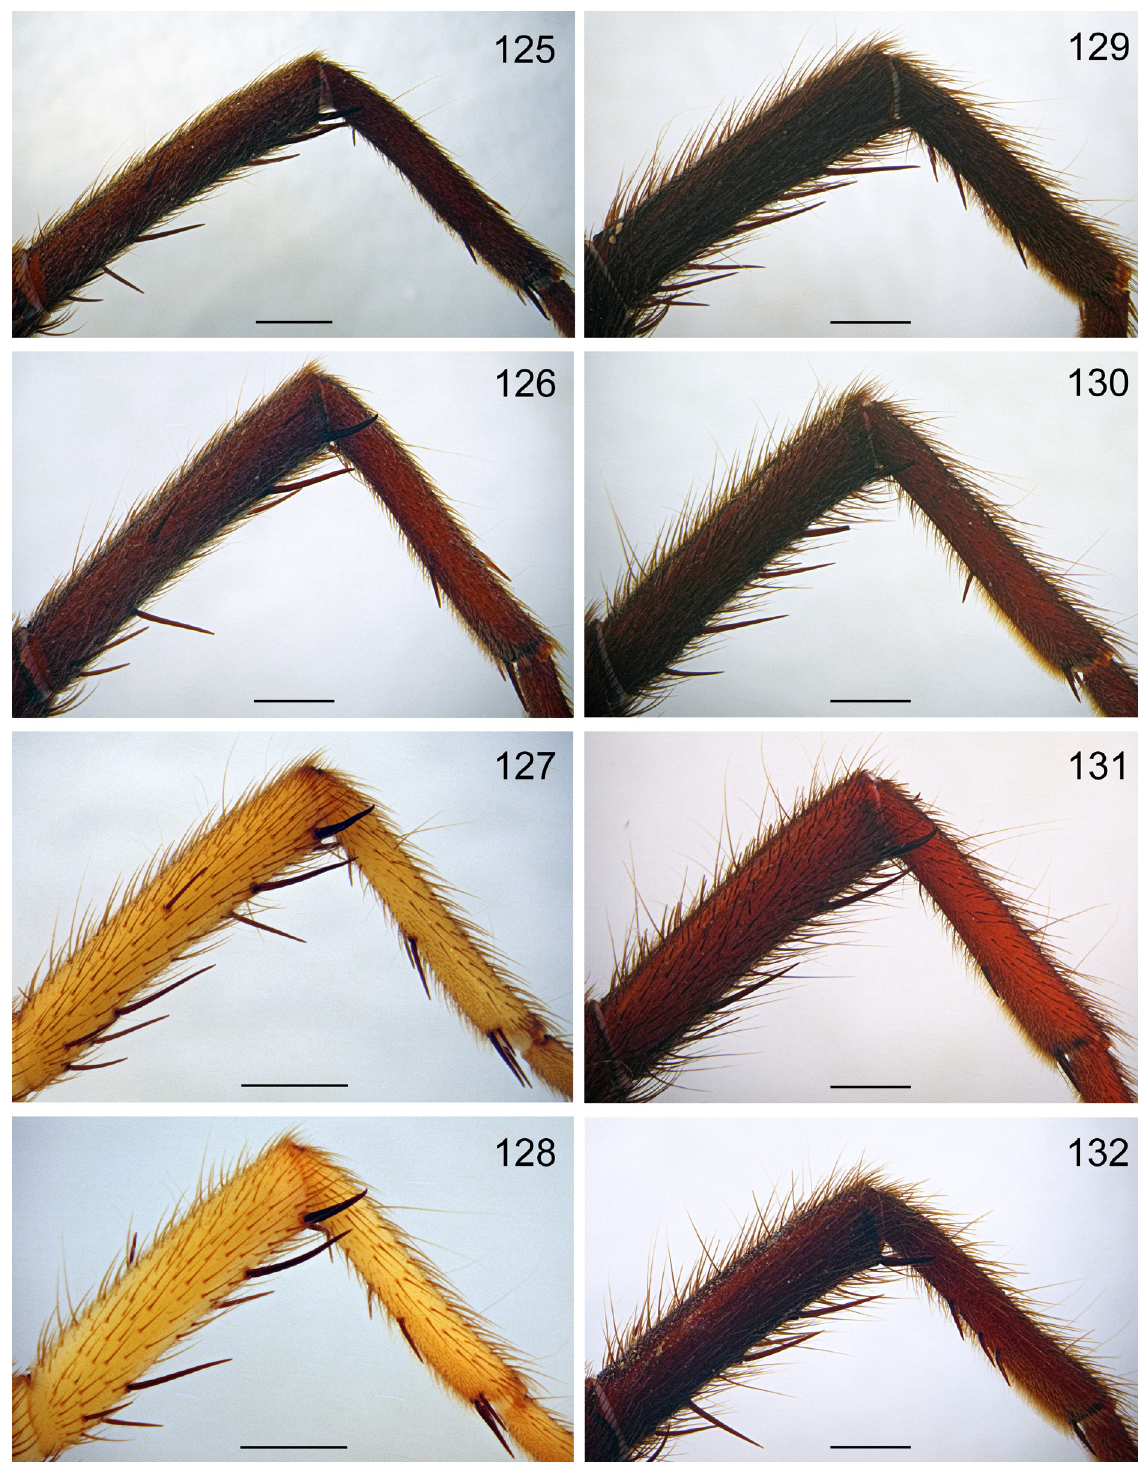
Figs 125–132. Anemesia spp., ♂♂, tibia and metatarsus I, retrolateral views. 125 . A. castanea sp. nov. (holotype). 126 . A. karatauvi (Andreeva, 1968) (Hojamaston). 127 . A. pallida sp. nov. (holotype). 128 . A. parvula sp. nov. (holotype). 129 . A. incana Zonstein, 2001 (holotype). 130 . A. infumata sp. nov. (holotype). 131–132 . A. infuscata sp. nov. (paratype from Sanglok Mts and holotype, respectively). Scale bars: 1.0